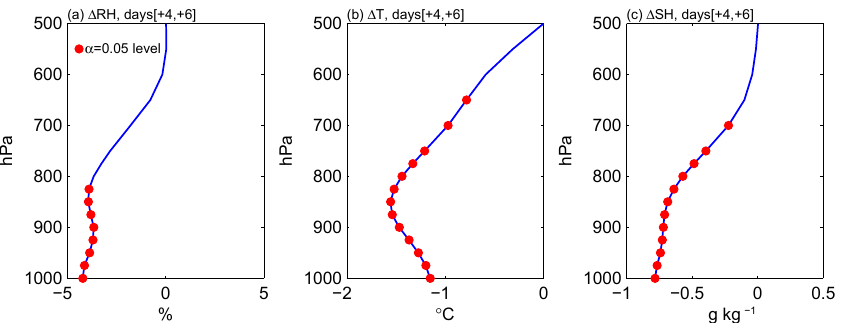
Figure 6. The vertical profiles of the relative humidity (a) , temperature (b) , and specific humidity (c) anomalies below 500hPa. The signifi- cance level is estimated using a left-tail t test, and the values significant at the 0.05 level are indicated with red